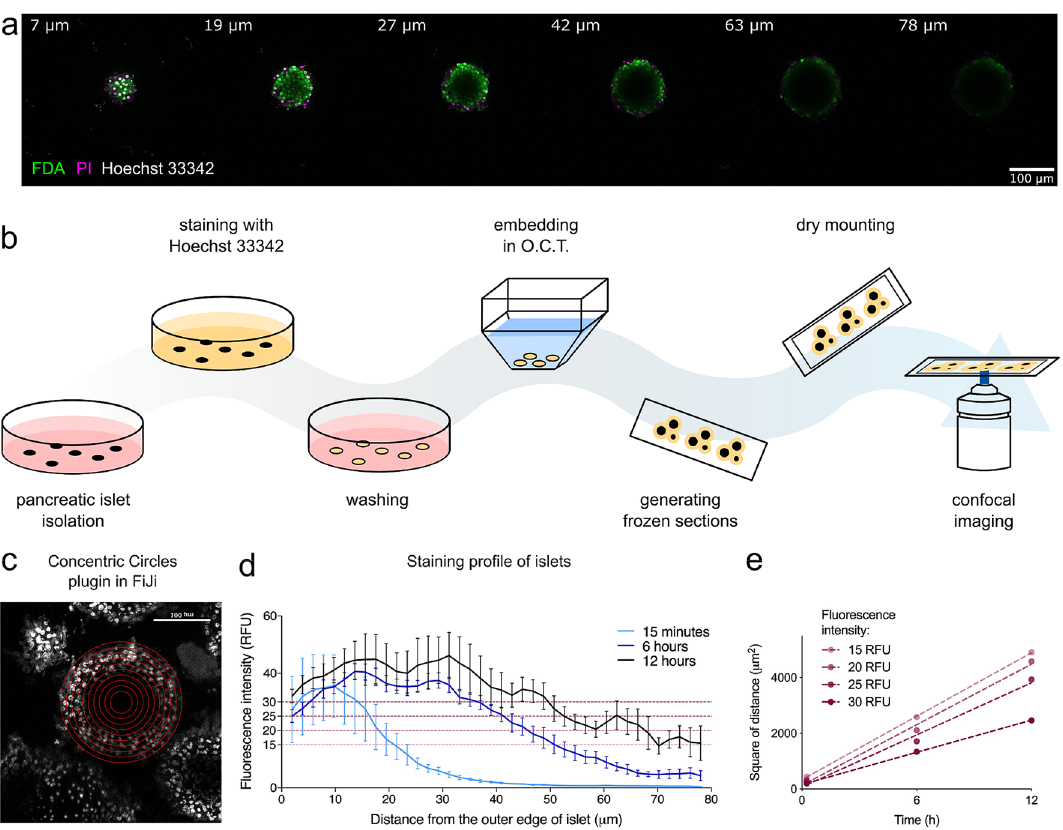
Figure 1. Molecular diffusion into islets—imaging and method development. ( a ) Lateral optical cross-sections of a pancreatic islet on top of a coverslip (unflattened) imaged by a confocal microscope (FDA/PI/Hoechst 33342 staining for 15 min at room temperature); each slice is labelled with distance in μm from the top of the islet. ( b ) Novel method to study diffusion: isolated pancreatic islets were incubated with Hoechst 33342 nuclear stain under different conditions, washed and immediately embedded into Optimal Cutting Temperature compound (O.C.T.) to stop the diffusion of the dye further into the islet. Frozen sections were cut on a cryostat and coverslip was added using a dry mounting method (double-sided tape) to prevent any exposure to moisture. Each slide was imaged immediately after being thawed to prevent further diffusion of the dye into the islet. ( c ) Confocal images of the sectioned islets were analysed using ImageJ plugin Concentric Circles. Parameters of the plugin were set to align with the outer edge of the imaged islet and to draw circles 5 pixels (corresponding to 1.89 μm) apart. Average intensity of each circle was measured, and results were plotted to show a staining profile. ( d ) Average staining profiles of pancreatic islets incubated with Hoechst 33342 at room temperature for 15 min, 6 h or 12 h (n = 3–5 islets). To get an average staining profile for a certain staining condition, profiles from multiple islets were aligned at the outer edge (0 μm). ( e ) Linear relationship between time and square of distance shown for four different fluorescent intensities from plot shown in ( c ). Figure ( b ) was created using Inkscape (version 0.91, http:// www. inksc ape. org/), figures ( d ) and ( e ) using GraphPad Prism (version 8.4.1, https:// www. graph pad. com). RFU relative fluorescence